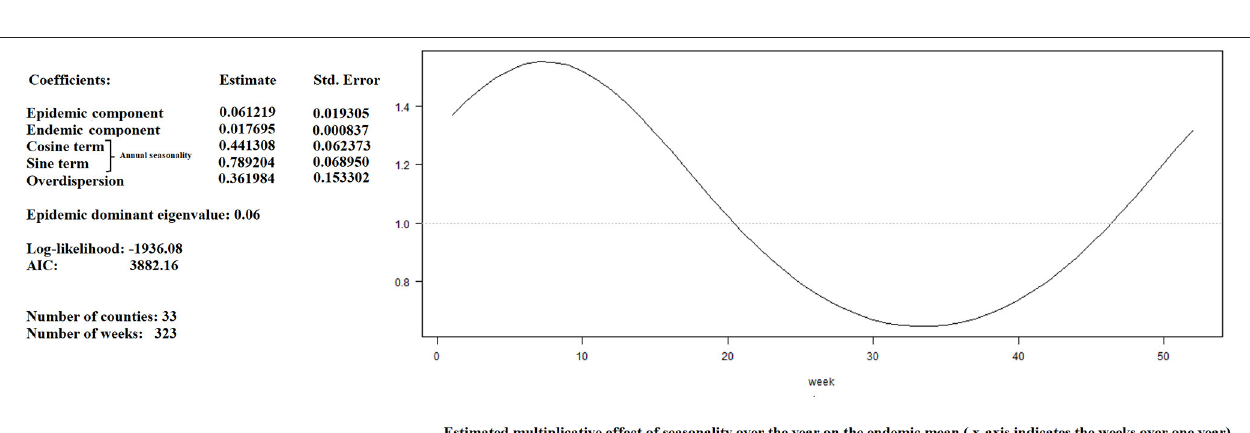
FIGURE 5 | Clinical events of porcine pleuropneumonia as presumptive diagnosis reported by week and by county in Northeastern Spain between January, 2012 and March, 2018.